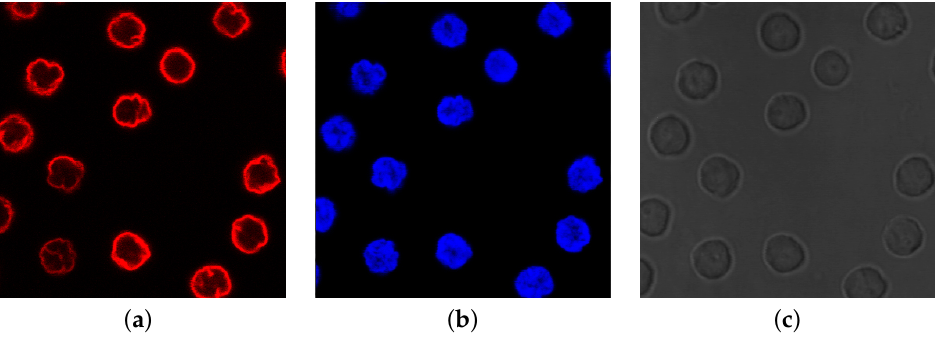
Figure 1. Example of differences in appearance of fluorescence and phase contrast microscopy images (culture of human lymphocyte cells [9]): ( a ) fluorescence image of nuclear envelope; ( b ) fluorescence image of interior nuclei (DNA); ( c ) phase contrast image of whole